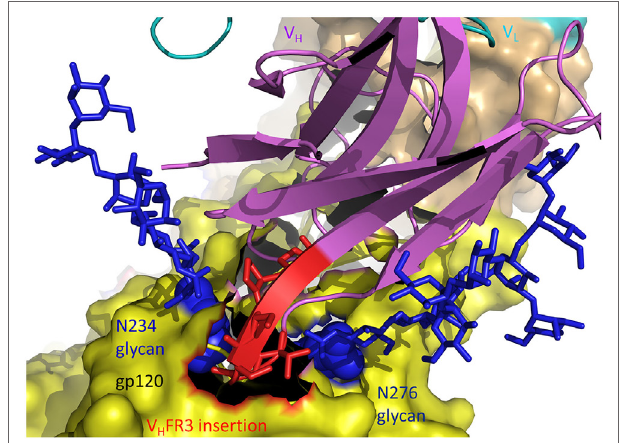
FiGURe 4 | Role of insertions in antibody affinity maturation. An insertion of five amino acids in V H framework region 3 (V H FR3) of matured antibody 8ANC195 enables V H FR3 to extend between the N234 and N276 glycans of envelope glycoprotein (Env) gp120 and contact protein beneath the glycan shield (5CJX) (20). V H and V L are magenta and cyan, respectively. The insertion in V H FR3 is red. Env gp120 (yellow) is drawn as a molecular surface. Glycans are represented as blue